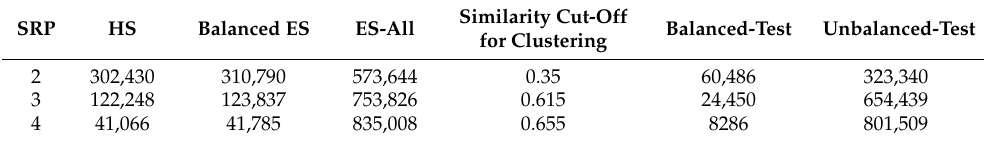
Table 2. ES and HS of different partition criterion.